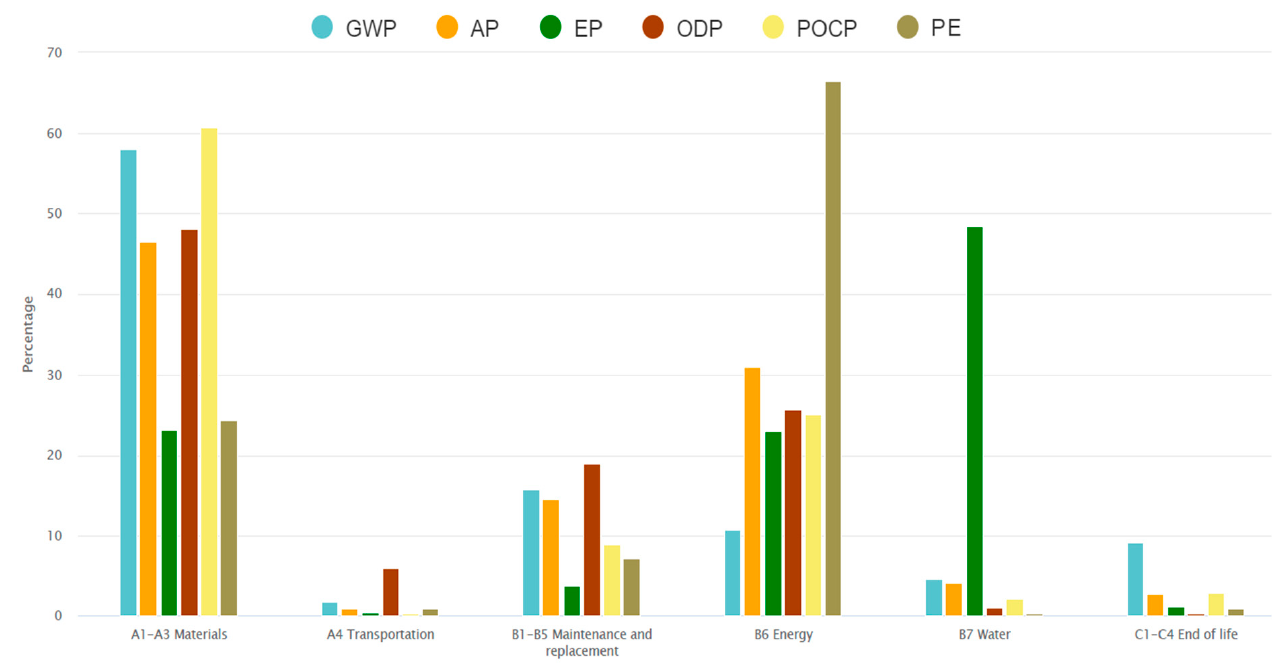
Figure 4. The LCIA results by percentage contribution of the life cycle stages to the environmental impacts of the An Corrán building. (GWP = Global Warming Potential, AP = Acidification Potential, EP = Eutrophication Potential, ODP = Ozone Depletion Potential, POCP = Photochemical Ozone Creation Potential, PE = Total Primary Energy excl. raw materials).